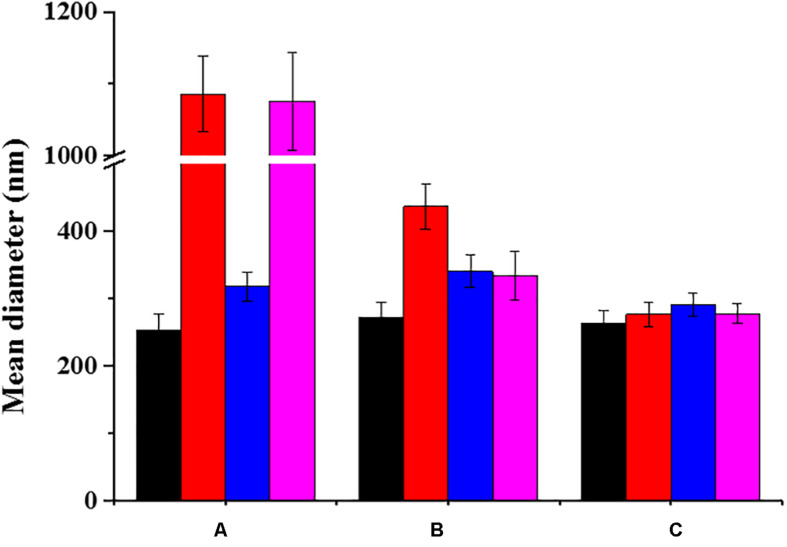
Colloidal stability of nanoMOFs in different media, before (A) and after surface functionalization with DOPC (B) or PEG-lipid conjugates (C). Mean hydrodynamic diameters of nanoMOF suspensions at 100 μg/mL were determined by DLS after 6 h incubation at 37°C. (Black: water; red: PBS; blue: DMEM supplemented with 10v/v% FBS; pink: DMEM without FBS).